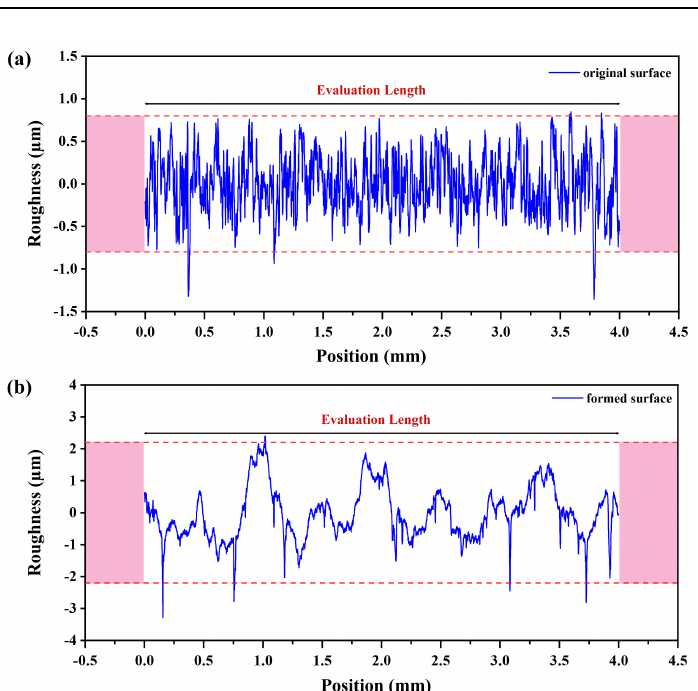
Figure 3. Measured surface profiles using Mitutoyo Surftest SJ-400 ( a ) original surface; ( b ) formed